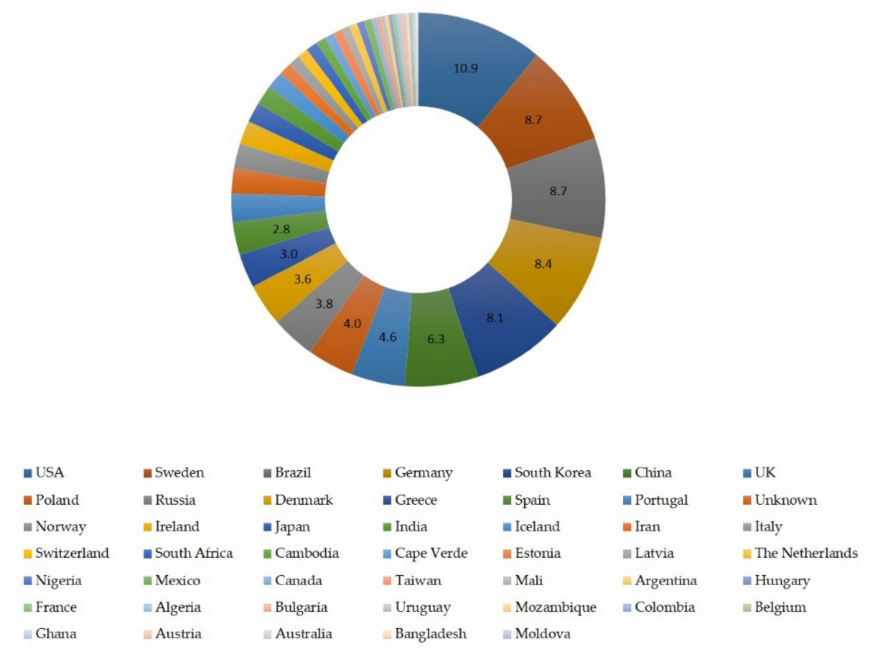
Figure 2. Ring pie chart of the frequency of S. epidermidis isolates in the MLST database ( n = 1593) according to the country of origin. MLST: multi-locus sequence typing.